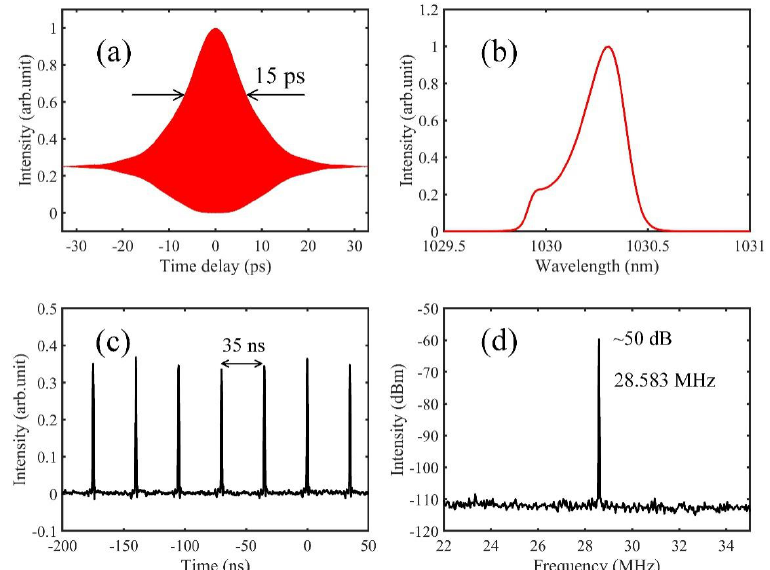
Figure 2. Characterization of the frequency comb source. ( a ) Pulse width measured by an autocorrelator. The pulse width is found as 15 ps; ( b ): Optical spectrum of the frequency comb source, measured by an optical spectrum analyzer (Thorlabs OSA201C); ( c ) Intracavity waveform, which is a stable pulse train with about 35 ns period; ( d ) Electrical spectrum, measured by a spectrum analyzer (Rigol DSA832) with 300 Hz RBW. The repetition frequency is 28.583 MHz with 50 dB signal-to-noise ratio.